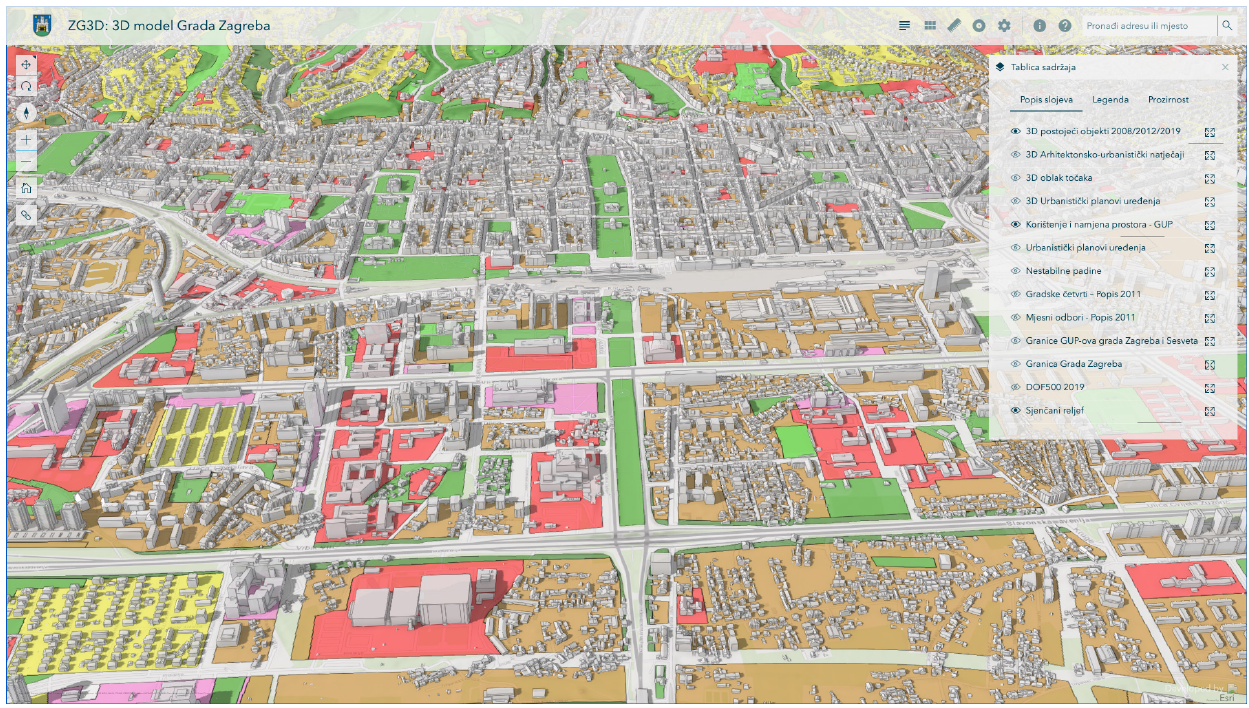
Figure 3. Building inventory dataset for the city of Zagreb (source: Office for Strategic Planning and City Development, City of Zagreb; URL: https://zagreb.gdi.net/zg3d/, last access: 15 February